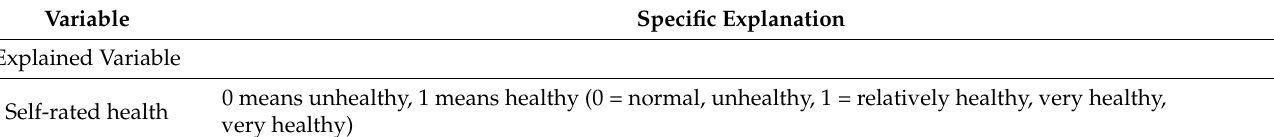
Table 1. Variable